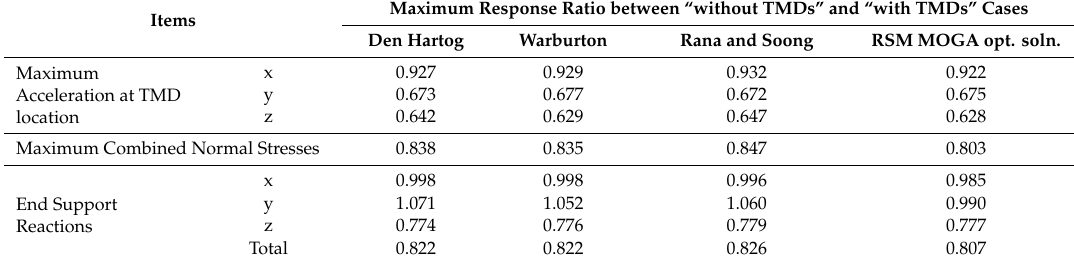
Table 5. Comparison of the maximum response ratios according to whether TMDs were installed and the di ff erence between the optimal design formula / methods.